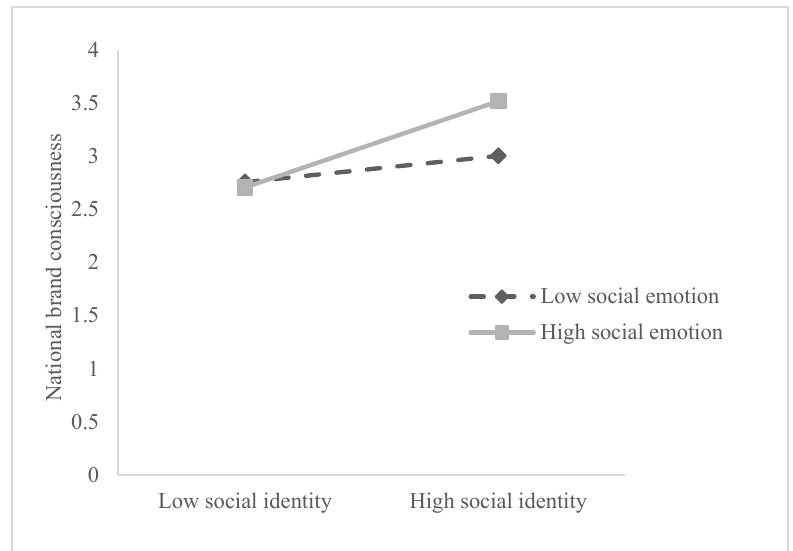
Figure 3. Moderating effect of social emotion on social identity and national brand consciousness.